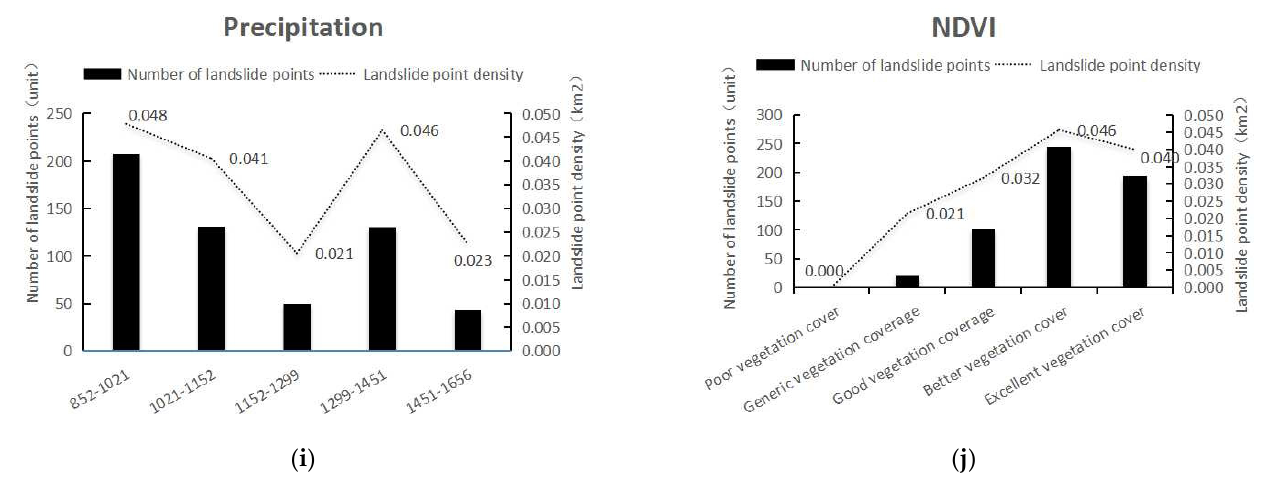
Figure 3. The density of disaster point at different levels of each factor: ( a ) land-use type; ( b ) elevation; ( c ) slope; ( d ) aspect; ( e ) proximity to rivers; ( f ) lithology; ( g ) proximity to faults; ( h ) proximity to road; ( i ) precipitation; ( j ) NDVI.